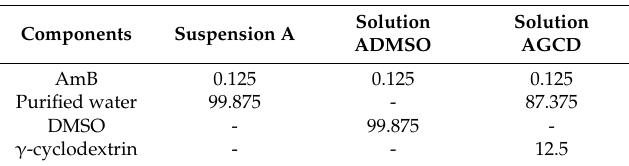
Table 2. Composition (%, w / w ) of the liquid formulations. Key: Suspension A is a liquid AmB simple reference formulation, ADMSO is an AmB solution reference formulation with DMSO, and AGCD is an AmB solution formulation with γ